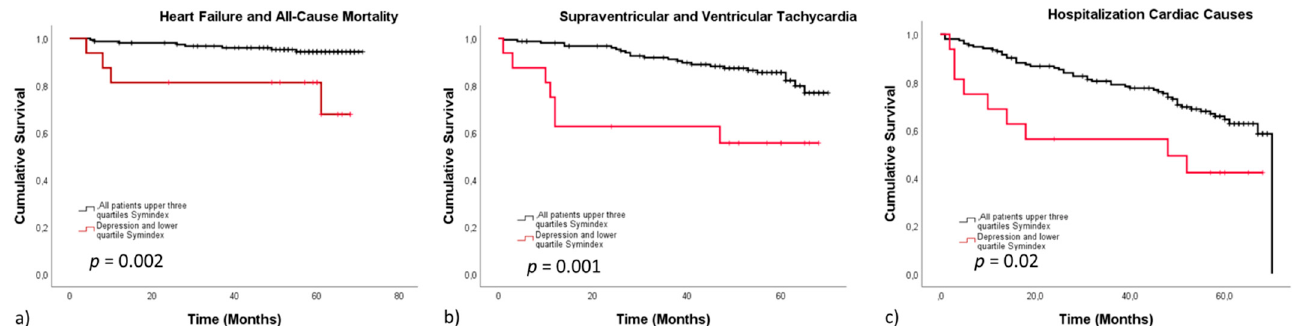
Figure 2. Survival stratified according to the lower quartile of the Symindex comorbid with MDD versus all other patients. The Kaplan–Meier curves display event free survival stratified according to the lower quartile of the Symindex comorbid with depression versus all other patients. Reduced heart rate variability associated with depression presented with a significantly lower event-free survival in all end-points, including heart failure and all-cause mortality ( a ), arrhythmias ( b ) and hospitalization due to cardiac causes ( c ).